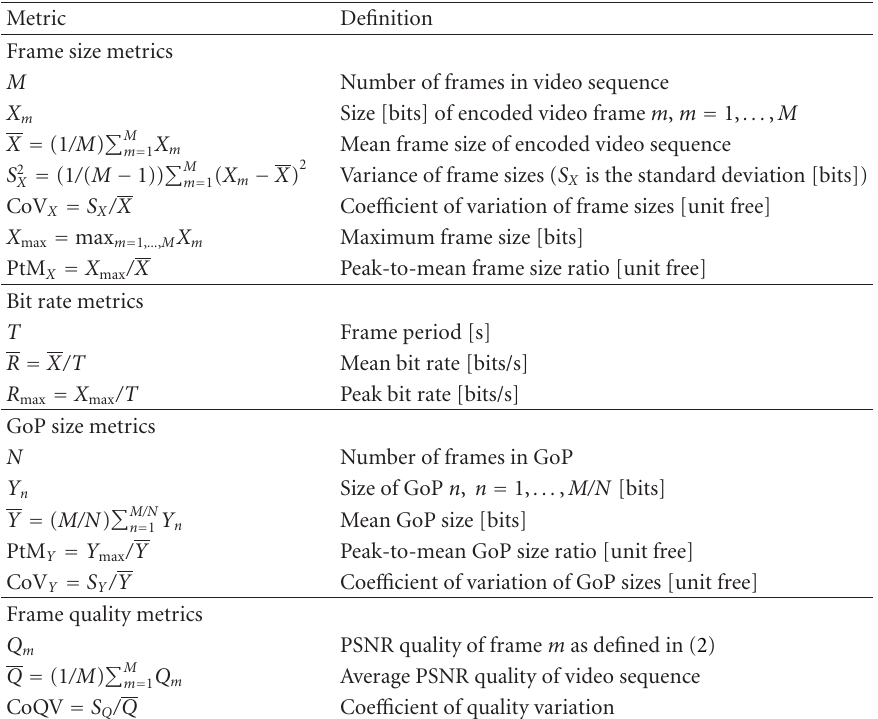
Table 1: Video tra ffi c and quality metrics for encoding with given quantization